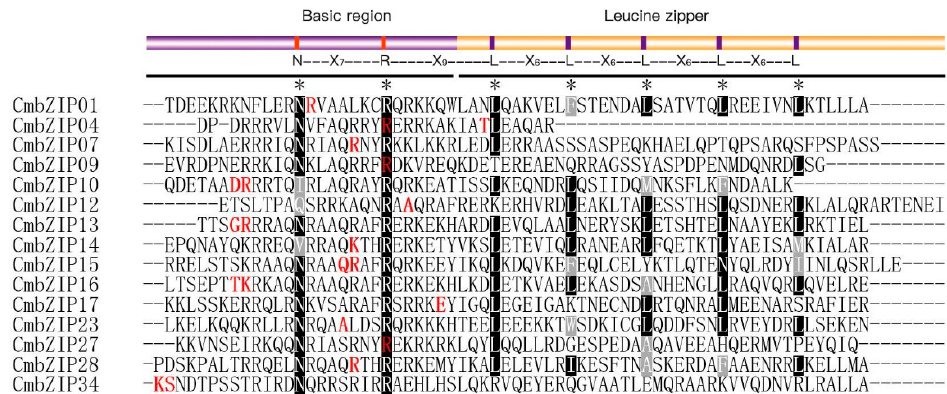
Figure 4. Analysis of splicing phase of intron in the bZIP domain of the CmbZIP proteins. Sequences handling is described as Figure 1. Splicing sites locate on the red letters. Single letter means splicing sites is located after the first or second nucleotide of a codon, and double letter means splicing sites is between two